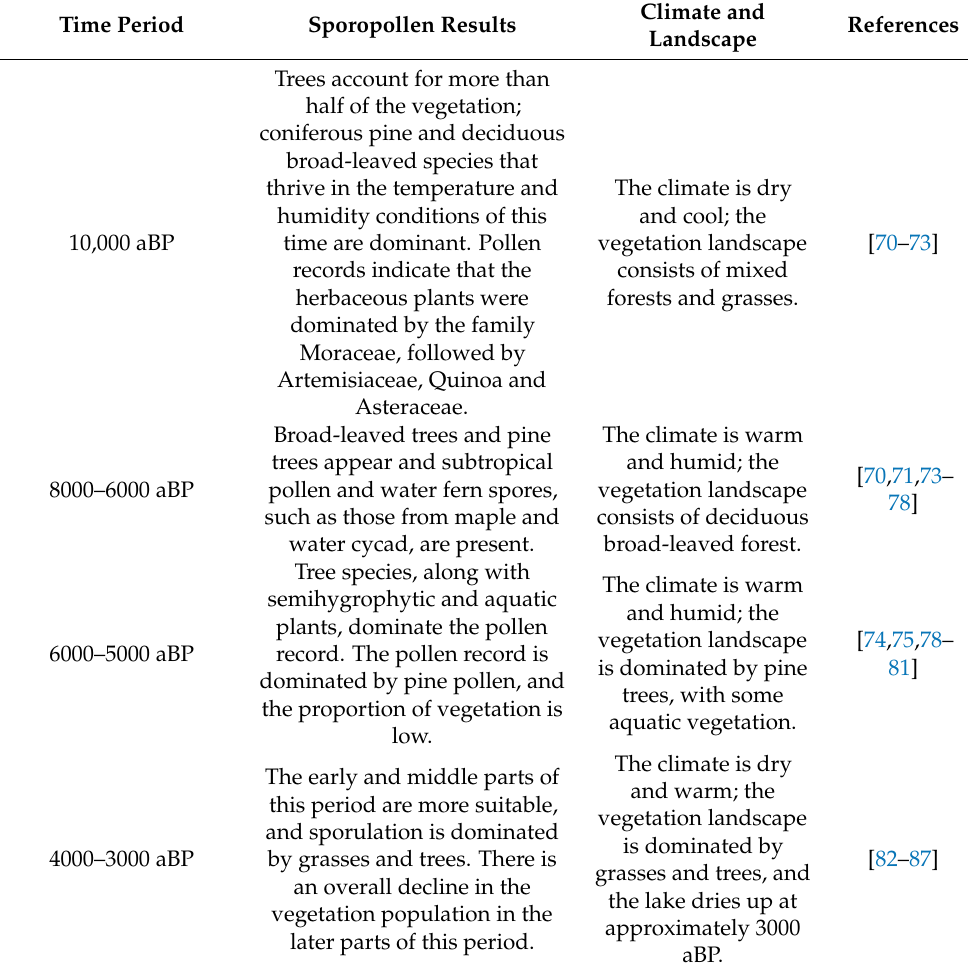
Table 2. Natural environmental changes at the SHS site area over 10,000